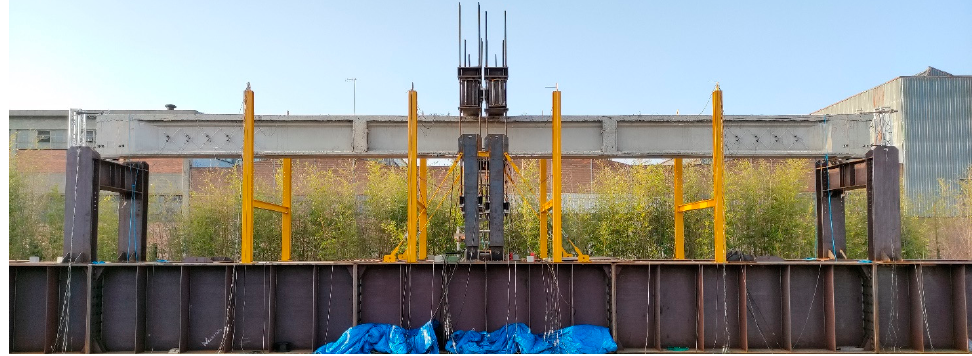
Figure 8. Three-point bending test configuration.